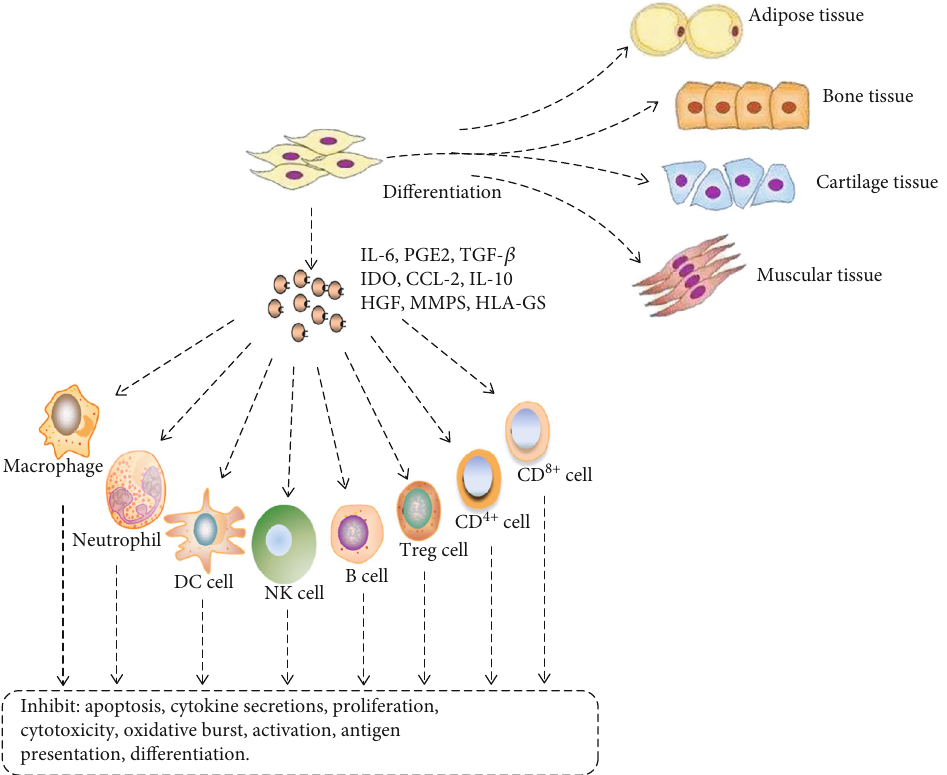
Figure 1: The general e ff ects of MSCs grouped under two major mechanisms: direct cellular di ff erentiation of recruited MSCs (into adipose, bone, cartilage, and muscle tissues) to replace damaged cells, and preparation of the in fl ammatory environment by MSC-secreted cytokines as they in fl uence the host immune system. IL-6: interleukin-6; PGE2: prostaglandin E2; TGF- β : transforming growth factor- β ; IDO: indoleamine 2,3-dioxygenase; CCL-2: C-C motive chemokine ligand 2; IL-10: interleukin-10; HGF: hepatocyte growth factor; MMPs: Matrix Metallopeptidases; HLA-Gs: Human Leukocyte